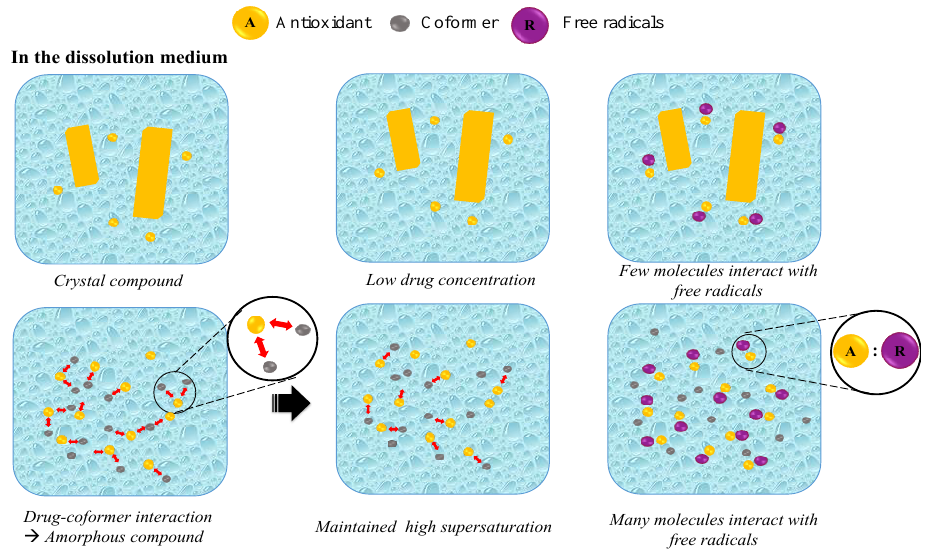
Figure 10. The schematic illustration of the antioxidant activity mechanism of the drug in a co-amorphous system.